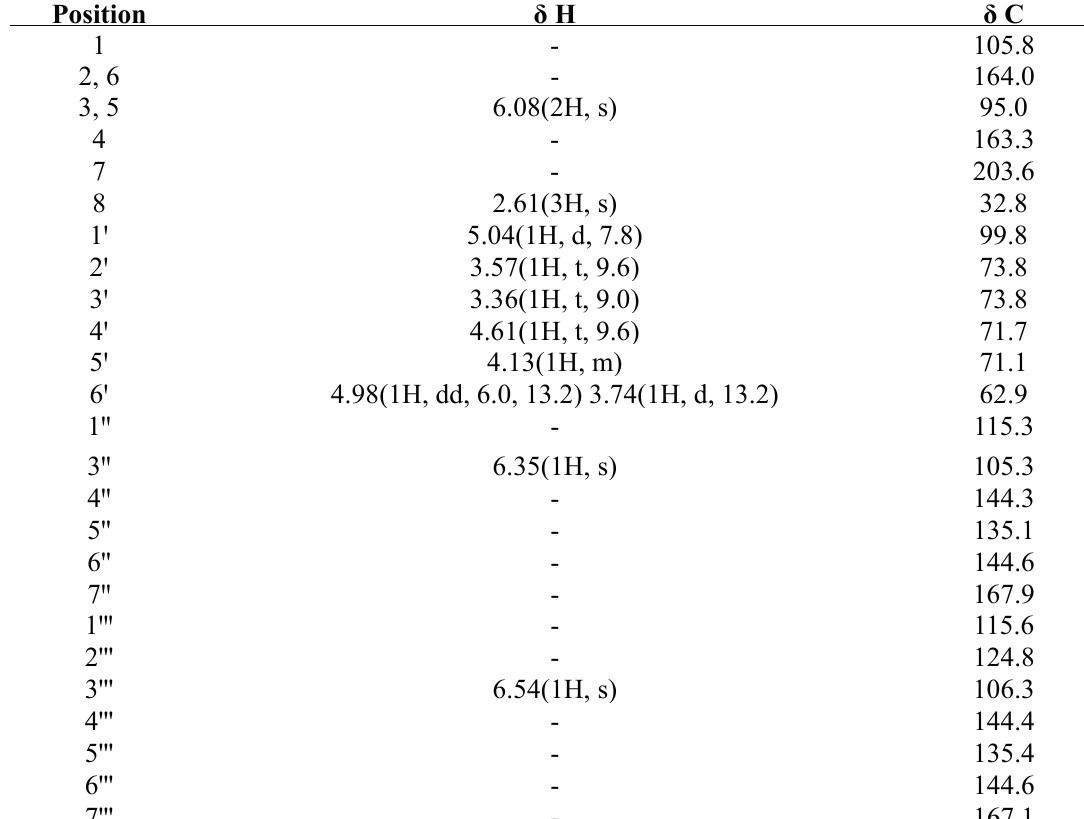
Table 2. 1 H (600MHz) and 13 C (150 MHz) NMR spectroscopic data of compound 2 in DMSO- d